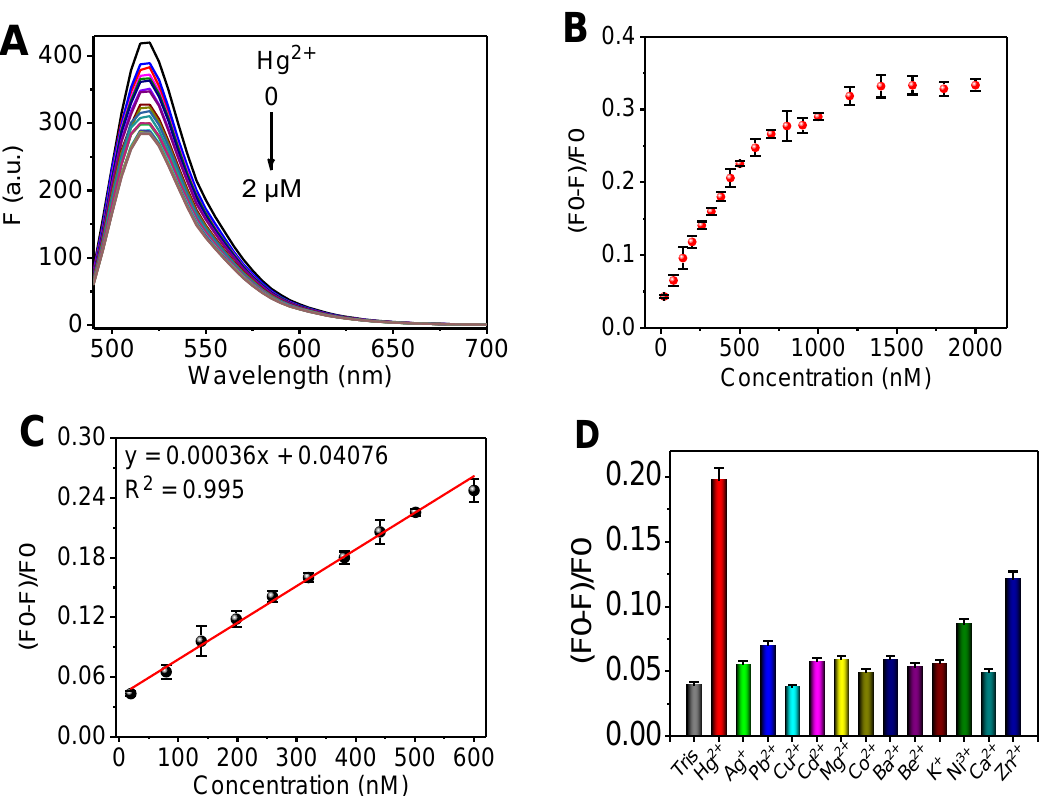
Figure 5. ( A ) Fluorescence emission spectra of T33–CoOOH complex (100 nM:4.69 μg/mL) upon addition of various concentrations of Hg 2+ (from top to bottom: 0, 20, 80, 139, 198, 259, 320, 381, 441, 500, 600, 700, 800, 900, 1000, 1200, 1400, 1600, 1800, and 2000 nM); ( B ) The dependence of the fluorescence intensity changes (F0 − F)/F0 at 520 nm on the concentration of Hg 2+ ; ( C ) The linear relationship between (F0 − F)/F0 and the Hg 2+ concentrations in the range from 20 to 600 nM; ( D ) The selectivity of the T33–CoOOH complex (100 nM:4.69 μg/mL) for Hg 2+ assay (Hg 2+ : 600 nM, other metal ions: 1.2 μM). Buffer: 5 mM Tris-HCl, pH 7.4.